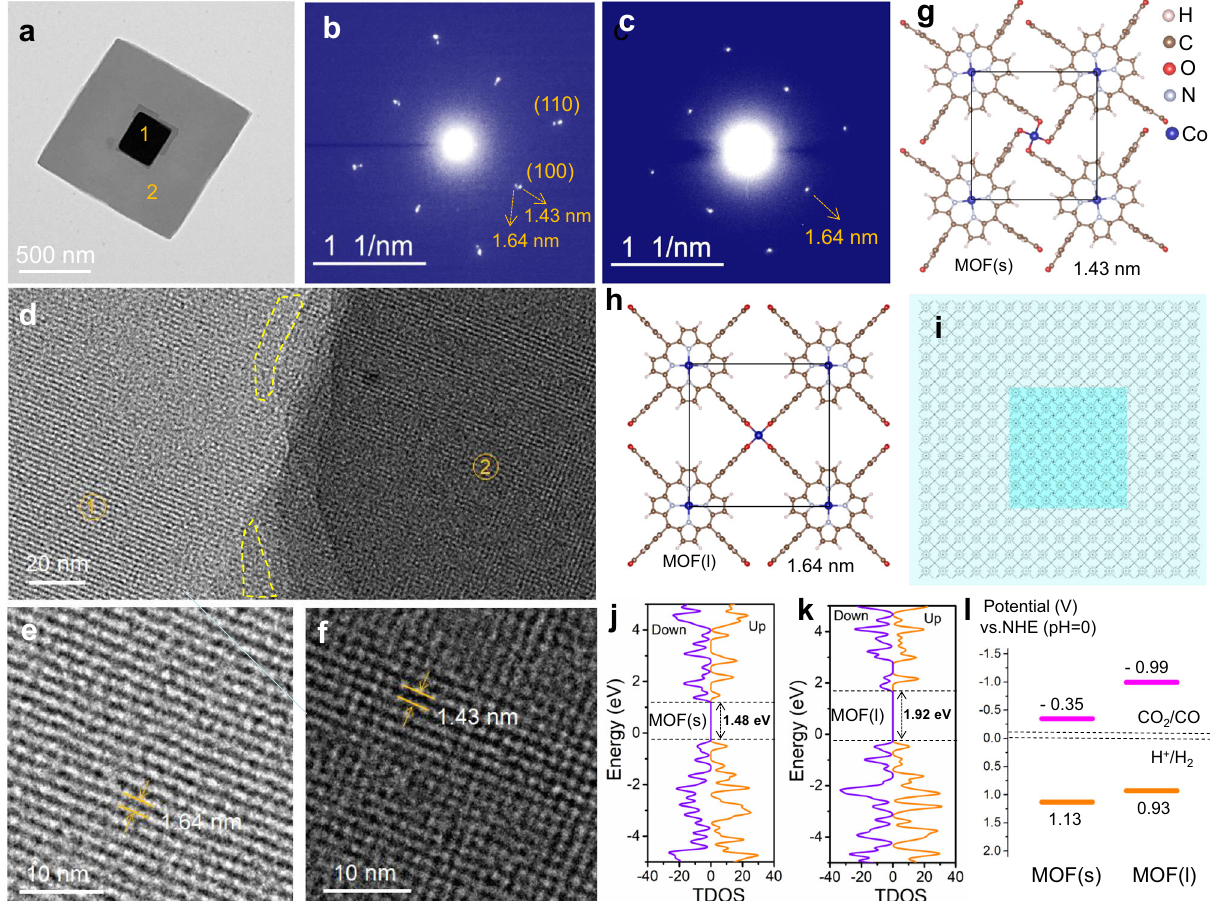
Fig. 2 Crystal structure of Co-MOF-3 nanostacks. a TEM image and b , c the corresponding SAED from the central (position 1 in a ) and peripheral (position 2 in a ) areas of Co-MOF-3, respectively. d HR-TEM image of the epitaxial inteface between the central and peripheral parts (yellow polygons represent interfacial dislocation). e , f Enlarged lattice image of position 1 in d and position 2 in d , respectively. g Cystal structural model of the smaller MOF, named MOF(s), in nanostacked Co-MOF-3. h Cystal structural model of the larger MOF, named MOF(l). The rectangular boxes in g and h highlight the unit cells. i Proposed top-view structure of Co-MOF-3 nanostacks. j , k TDOS plots of monolayer MOF(s) and MOF(l) in nanostacks, respectively. l Calculated energy levels of monolayer MOF(s) and MOF(l) in nanostacks (Potential vs. NHE (pH =